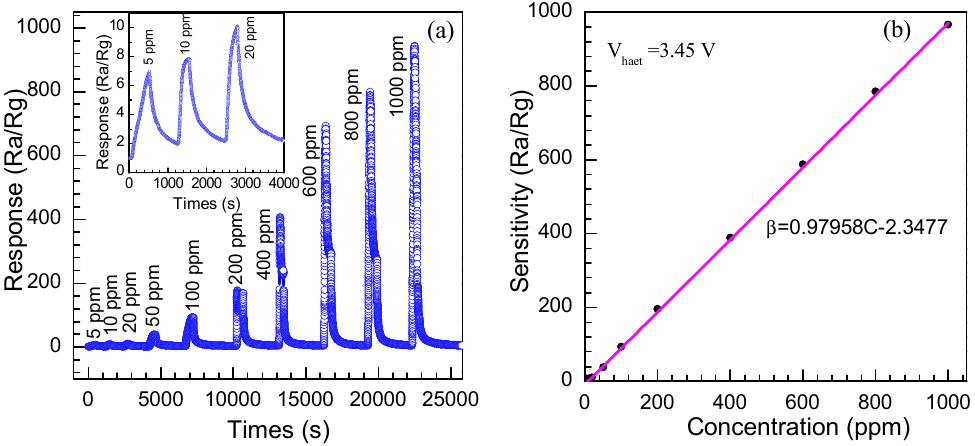
Figure 12. ( a ) Dynamic response-recovery periods curve of the sensor to ethylene glycol gas with the concentration ranging from 5 to 1000 ppm at the optimum operating voltage of 3.4 V. Inset: the enlarged response-recovery periods curve ranging from 5 to 20 ppm. ( b ) Linear relationship between the gas response and different concentrations of ethylene glycol.